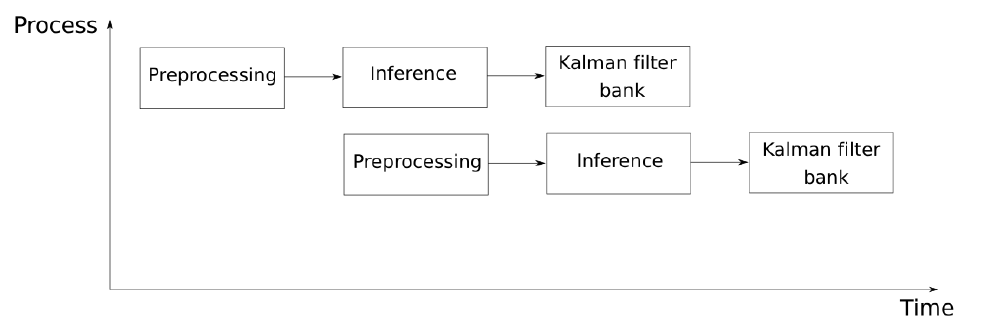
Figure 8. Pipelined